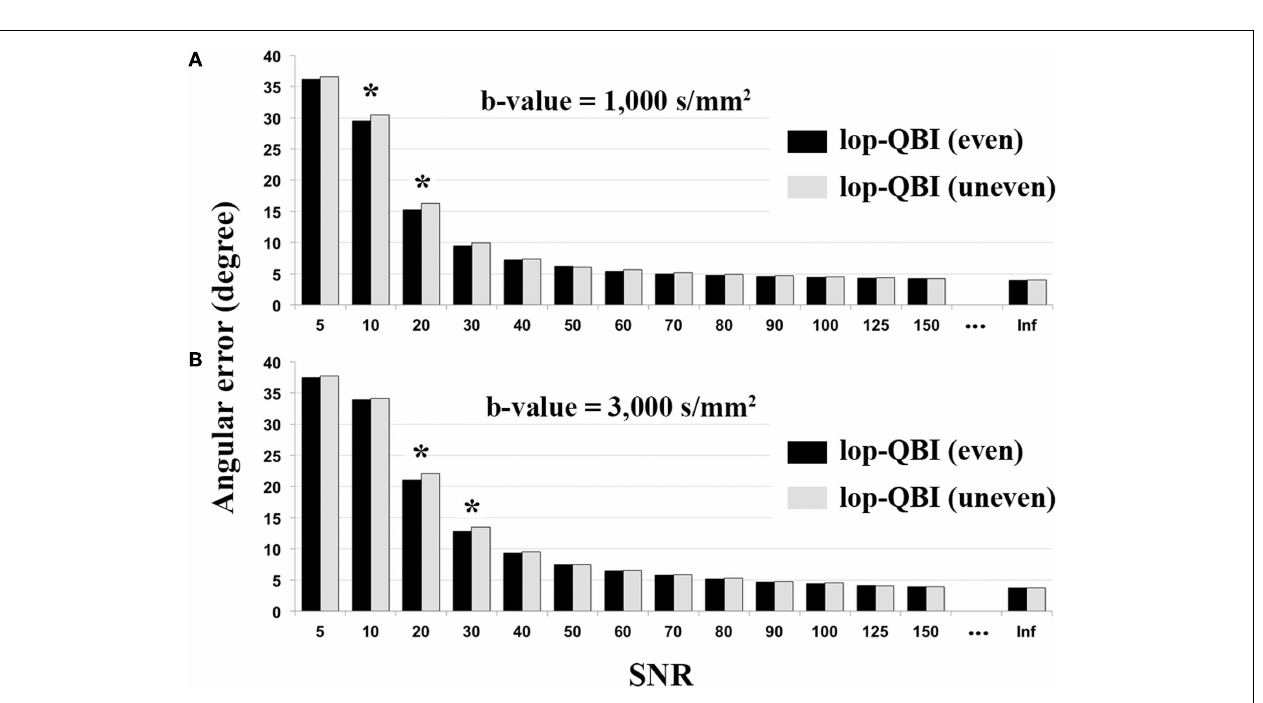
FIGURE 7 | Mean of angular error between fibers of digital phantom and the ground truth, measured from evenly sampled lop-DWI (Figure 1A) and unevenly sampled lop-DWI (Figure 1B), across different SNRs .